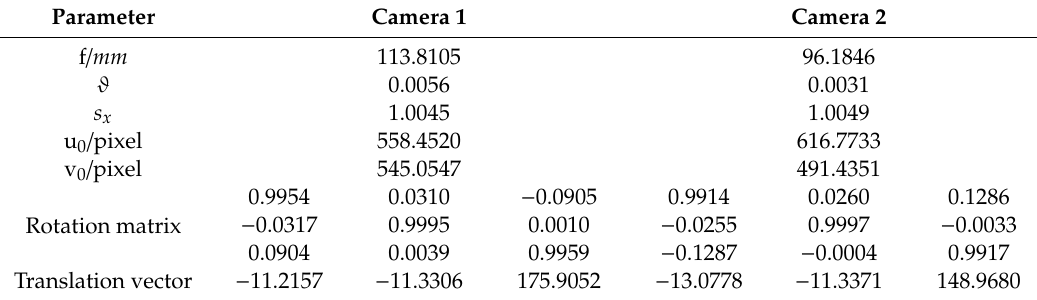
Figure 12. The calibration of a COM-SLM. ( a ) Calibration device and ( b ) target (ref. [34], Figures 5 and 6). Table 2. Parameters of the imaging system with the modified method.